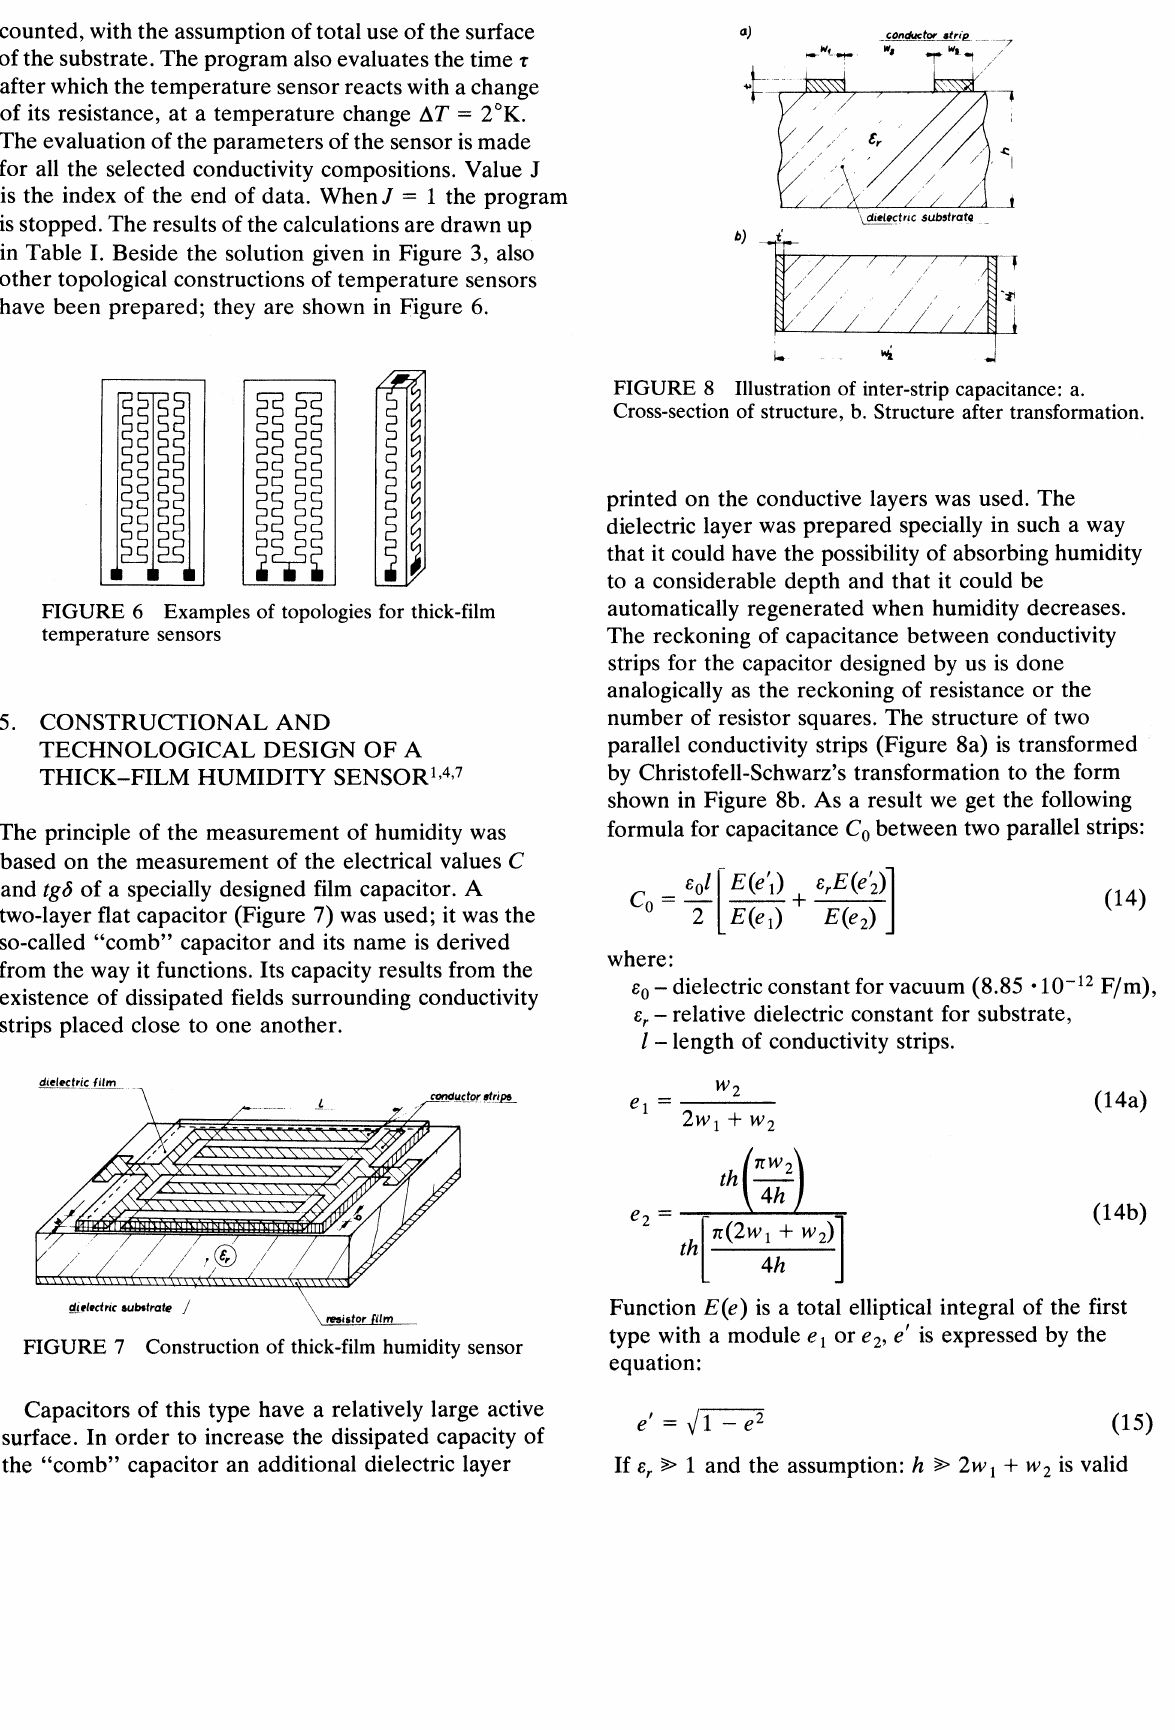
FIGURE 7 Construction of thick-film humidity sensor